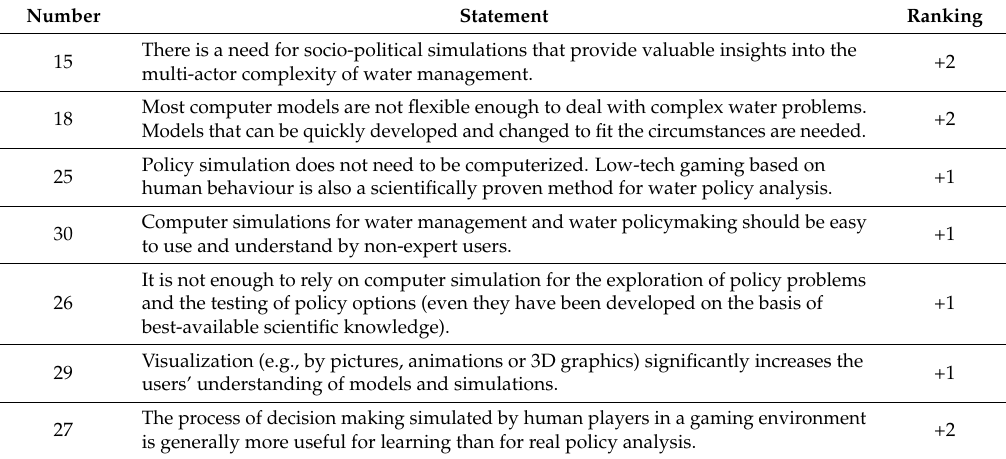
Table 14. Distinguished statements about MSG in frame